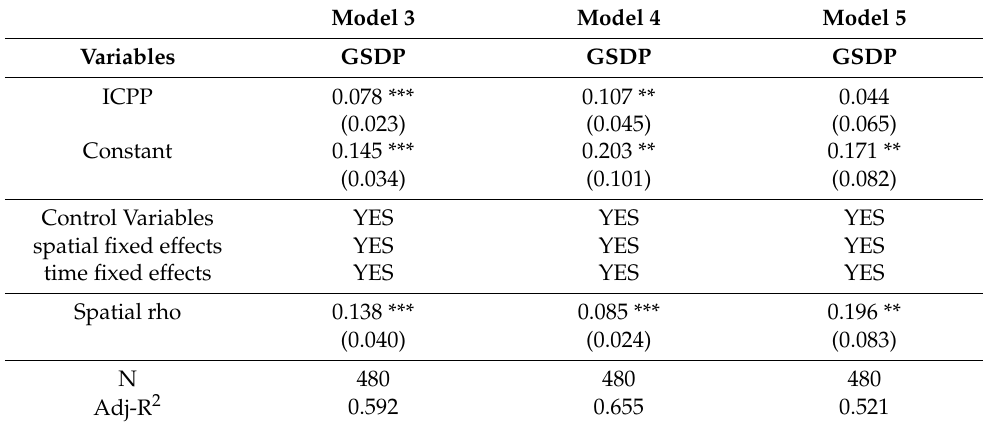
Table 5. The regression results of the robustness